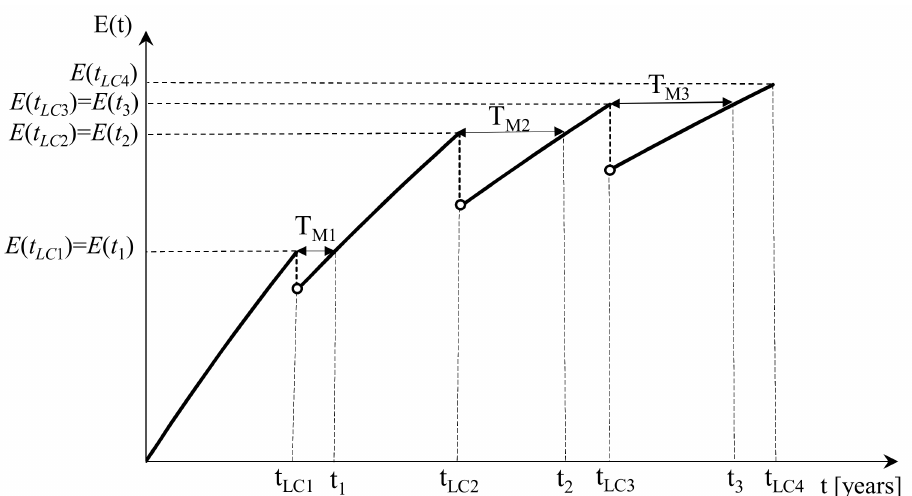
Figure 2. A graphical interpretation of the integrated e ffi ciency indicator in the lifecycle (dependency (7)), including the sustainable modernization indicator (dependence (20)) and the time of the return on costs for modernization (dependence